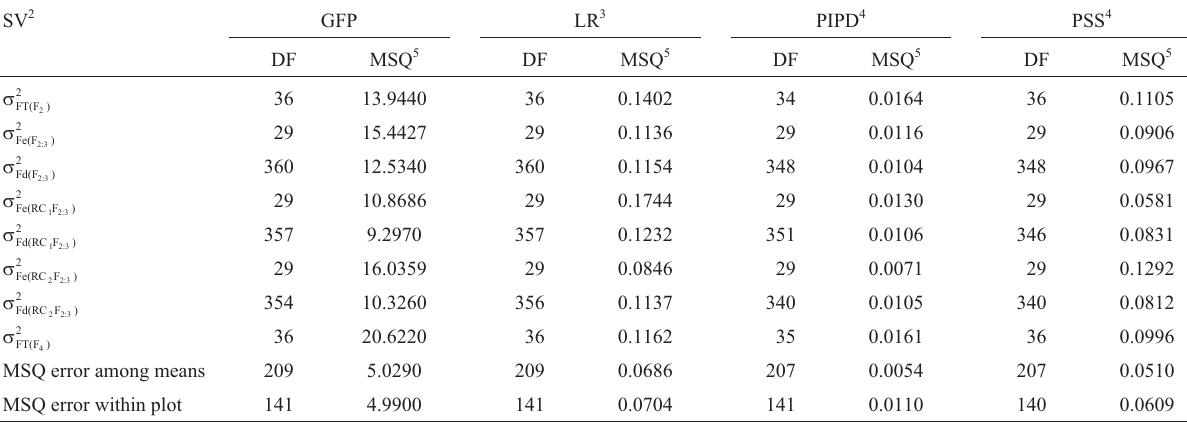
Table4 -Informationemployedinthejoint-scaletestforobtainingestimatesofgeneticadditive( (cid:2) (cid:3) A2 ),dominance( (cid:2) (cid:3) D2 )andenvironmental( (cid:2) (cid:3) E2 )variances, using weighted least-squares (Mather and Jinks, 1984) for traits associated to resistance against the stink bug complex (GFP, LR, PIPD and PSS) 1 in soy- bean. SV 2